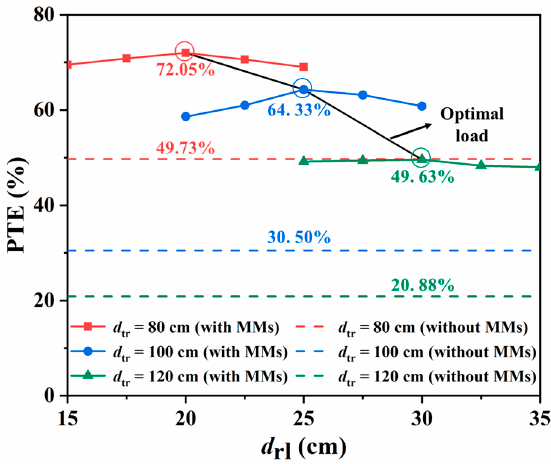
Figure 10. Measured PTE as a function of the d rl.